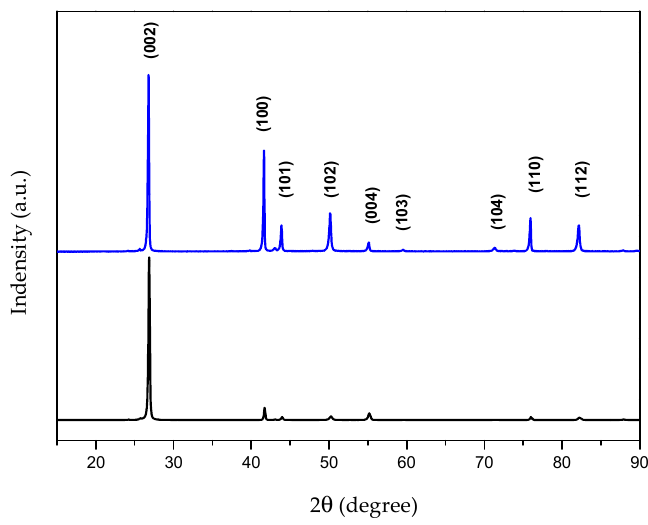
Figure 18. X-ray diffraction recorded on both pellet surface ( blue ) and pellet cross-section ( black ).